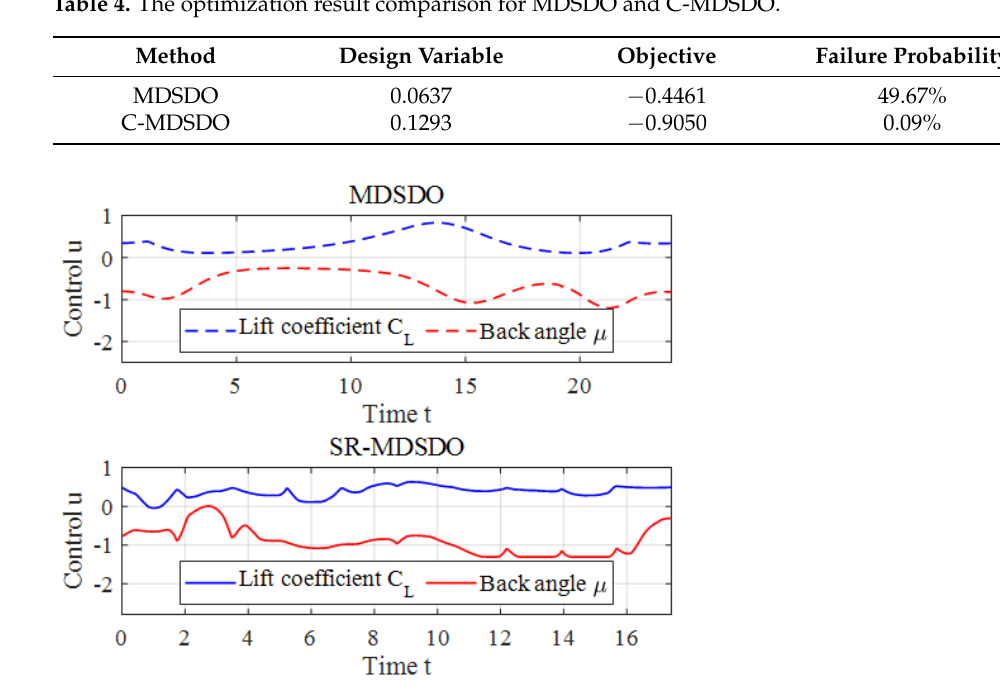
Table 4. The optimization result comparison for MDSDO and C-MDSDO.